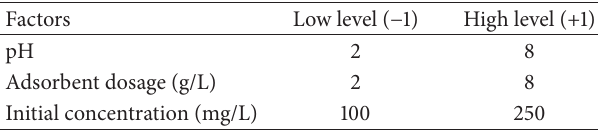
Table 1: High and low levels of factors. Table 2: The results for ultimate and proximate